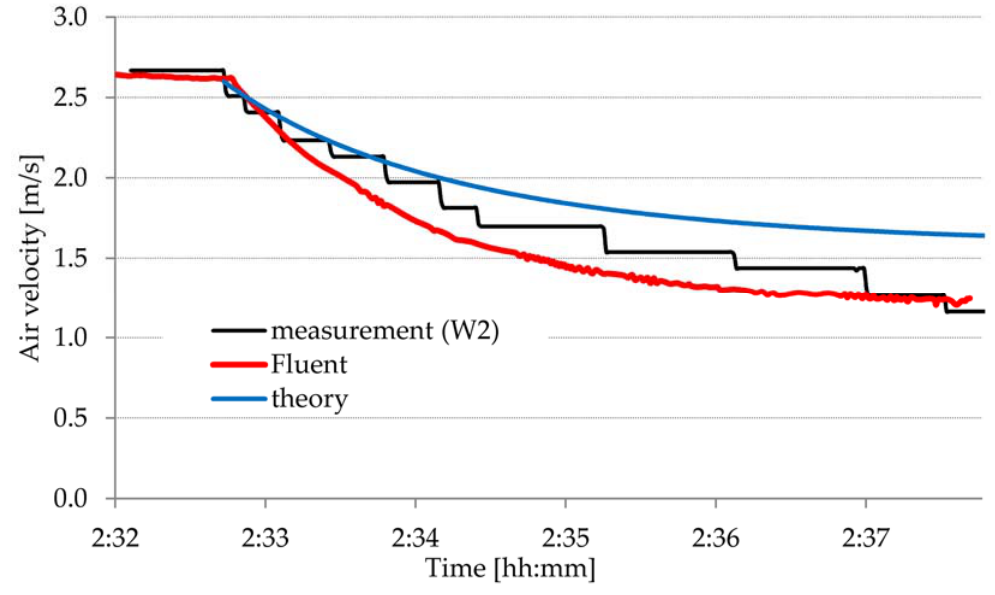
Figure 8. Transient case 3: “1 norm” → “0”.